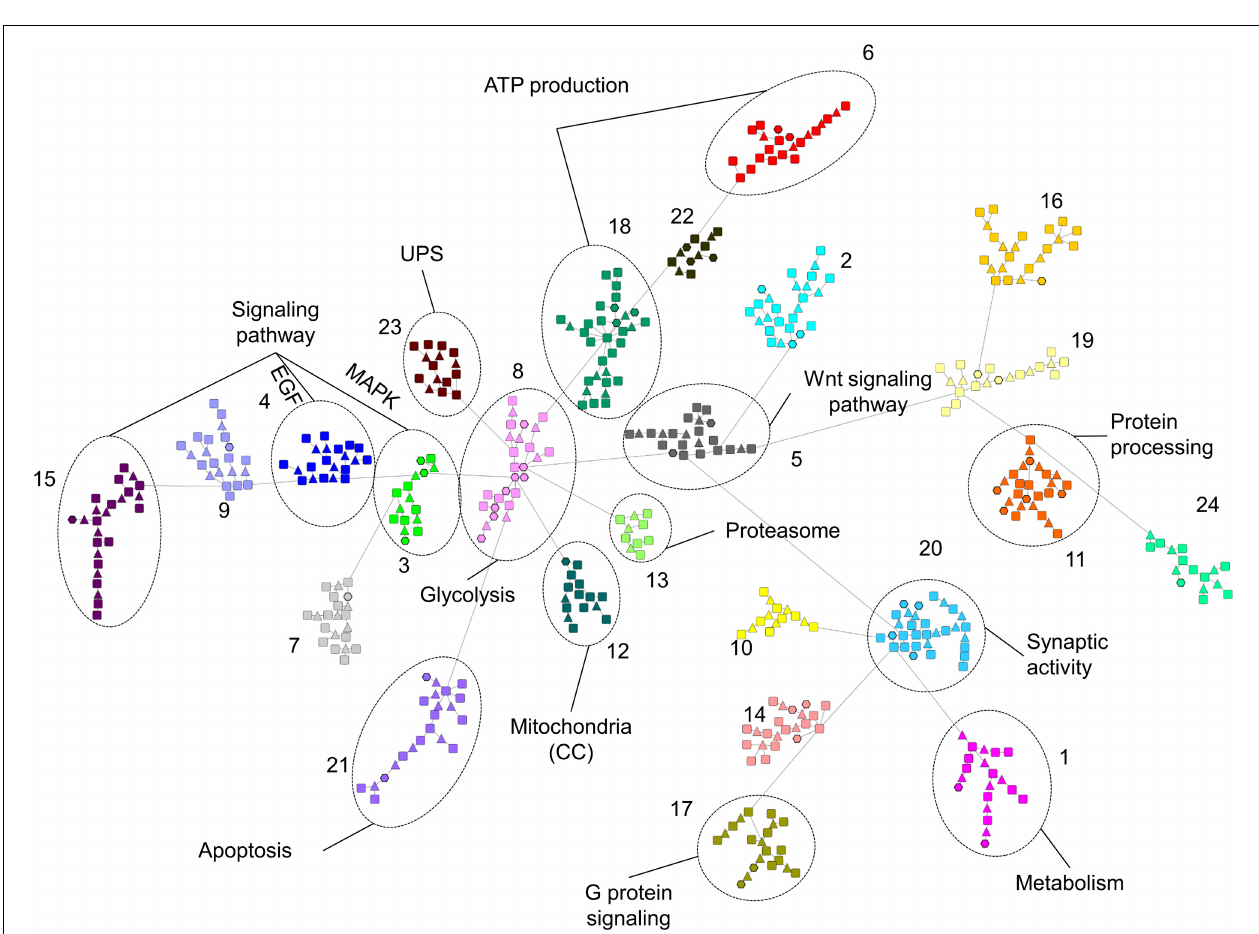
FIGURE 3 | Subnetwork clustering of the D2 model of the META list, using the community detection algorithms of GLay. Subnetworks are evidenced by different colors and numbered. Unambiguously over-represented categories are indicated. See Supplementary Tables 9, 10 for